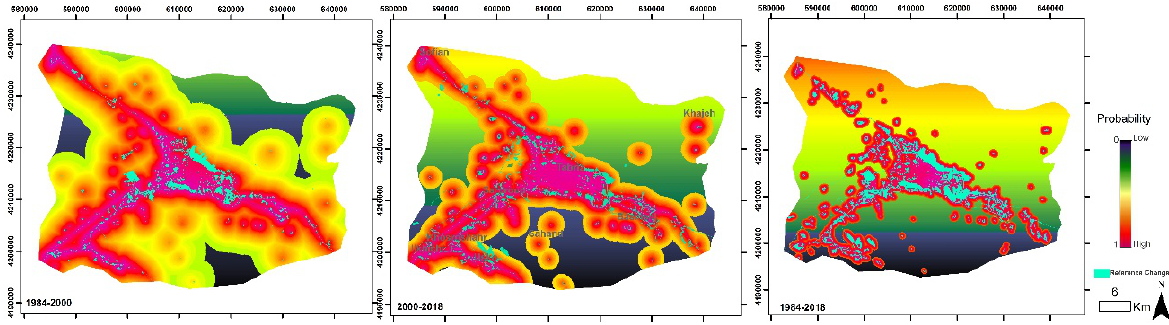
Figure 6. Urban growth probability maps of the TMA in three periods based on LR data. As shown in Figure 6, the high-probability urbanization cores are mainly located along main roads and are connected to previous urban centers. Non-connected centers away from cities indicate the possibility of rural area development, which increases the likelihood of growth in the vicinity of the main core of cities. Urban change maps were nominal as a dependent variable in the LR model in the preparation of the urbanization probability map. Furthermore, the independent variables in the mentioned model were converted to a normal form in order to calculate R2